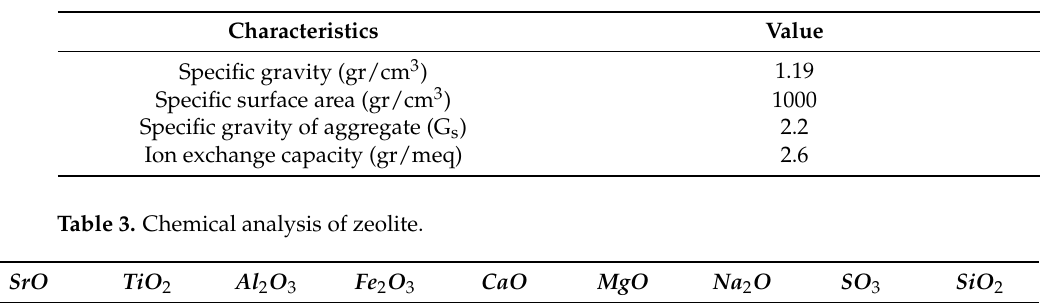
Table 2. Physical and chemical properties of the zeolite.